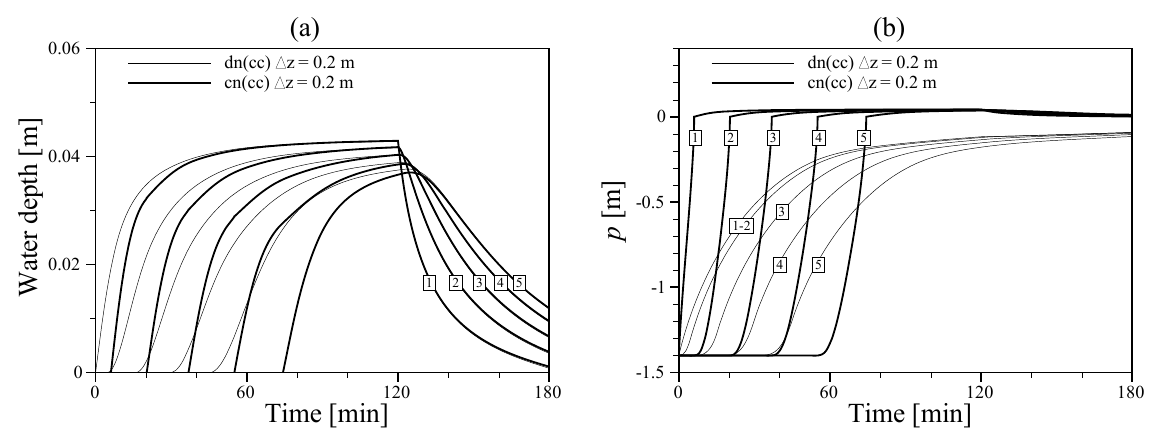
Figure 13. Simulated values for excess infiltration (third scenario) on a hillslope with a cell-centered scheme and (cid:49)z = 0.2m. (a) Water depths at the surface nodes. (b) Pressure heads at the topmost subsurface nodes. Nodes are numbered 1–5 in the downslope